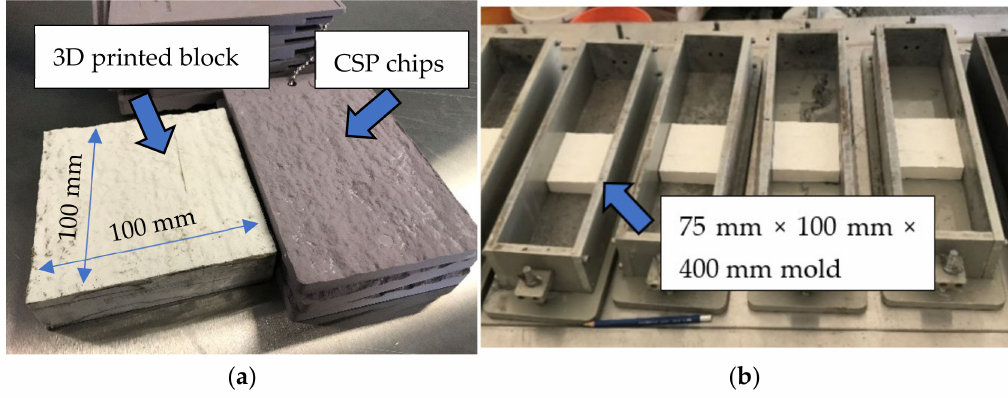
Figure 3. Mold preparations ( a ) 3D printed block and #6 CSP chip ( b ) 3D printed blocks in molds.